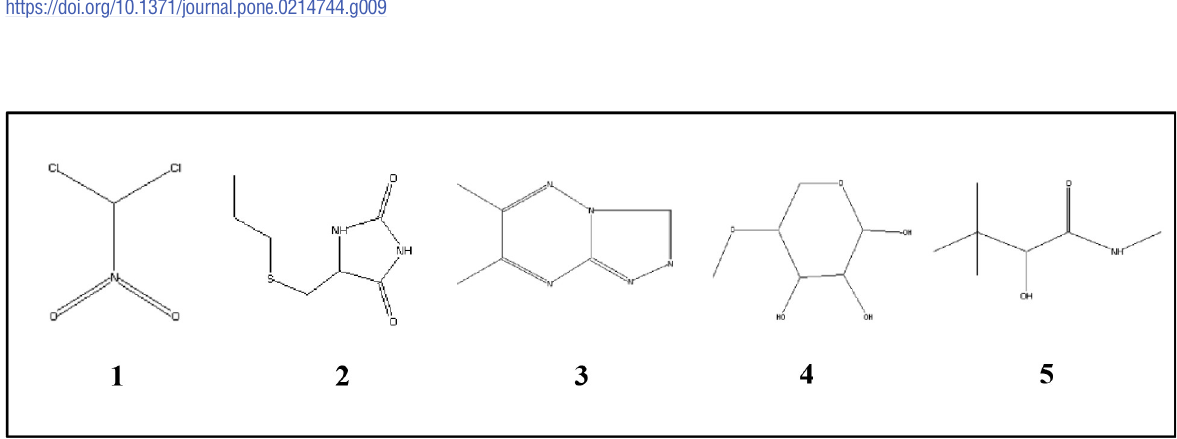
Fig 10. Chemical structures of five different compounds identified from band-D of EA fraction of AE1 by GC-MS analysis as mentioned in Table 4.